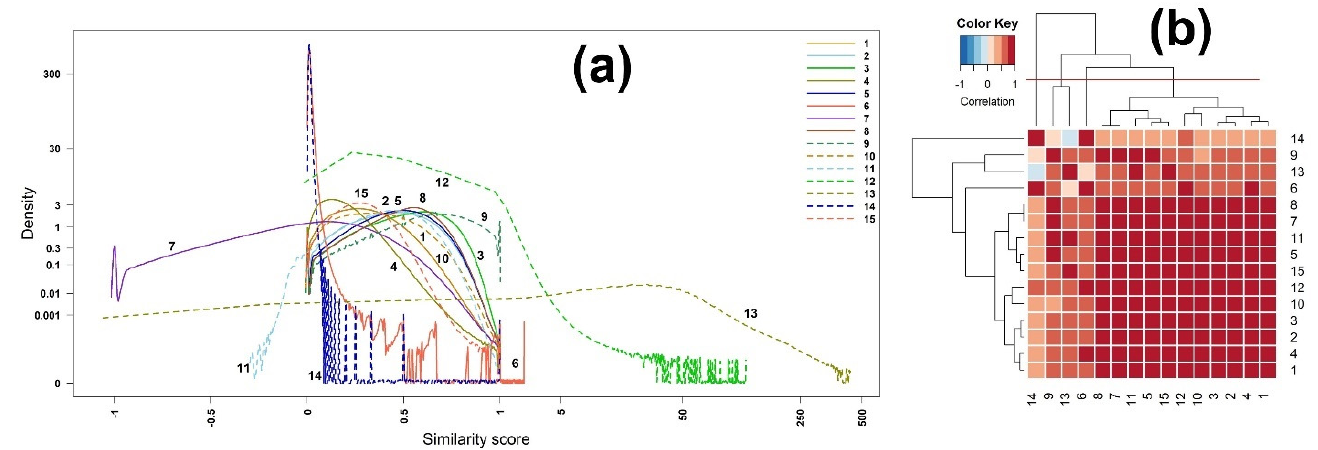
Figure 1. ( a ) Densities and ( b ) heatmap of the correlation matrix of scores among 15 binary similarity measures for EI mass spectra-based compound identification. The correlation was calculated using Pearson’s correlation coefficients. The horizontal red solid line indicates the four clusters generated by hierarchical clustering. The numbers in row and column represent the indices of binary similarity measures corresponding to Table 4 of Section 4.